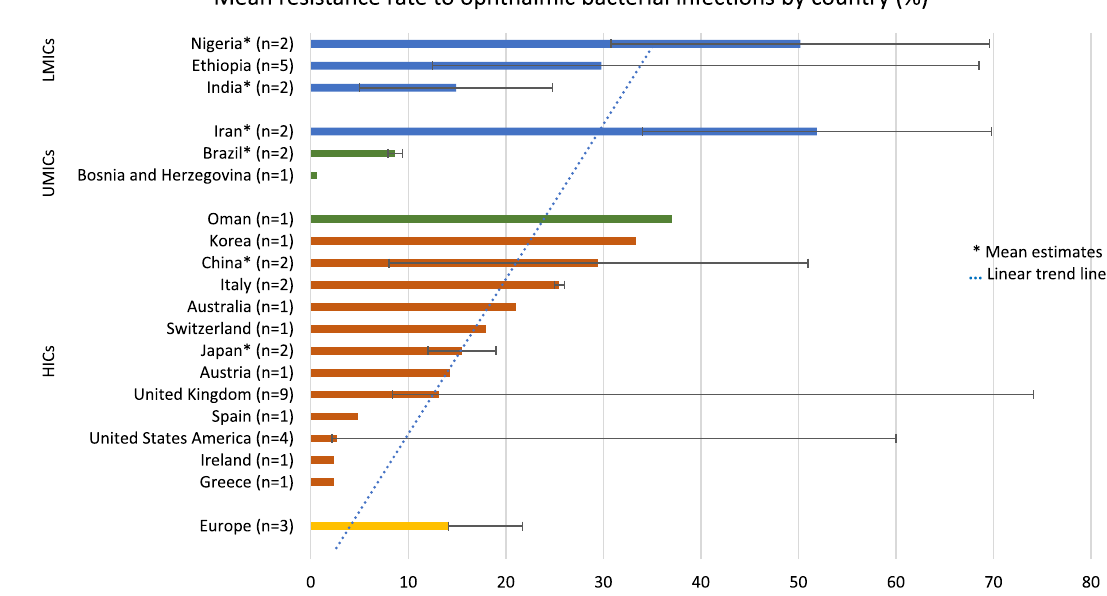
Fig. 2 Graphical representation of the mean resistance rate to chloramphenicol by